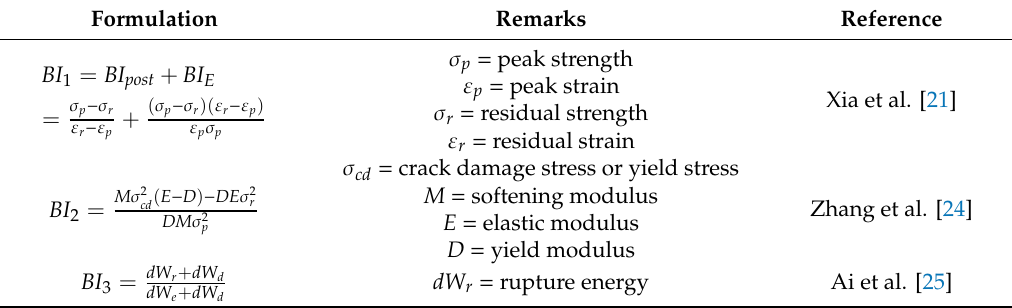
Table 1. Summary of several current brittleness indexes that are based on energy balance